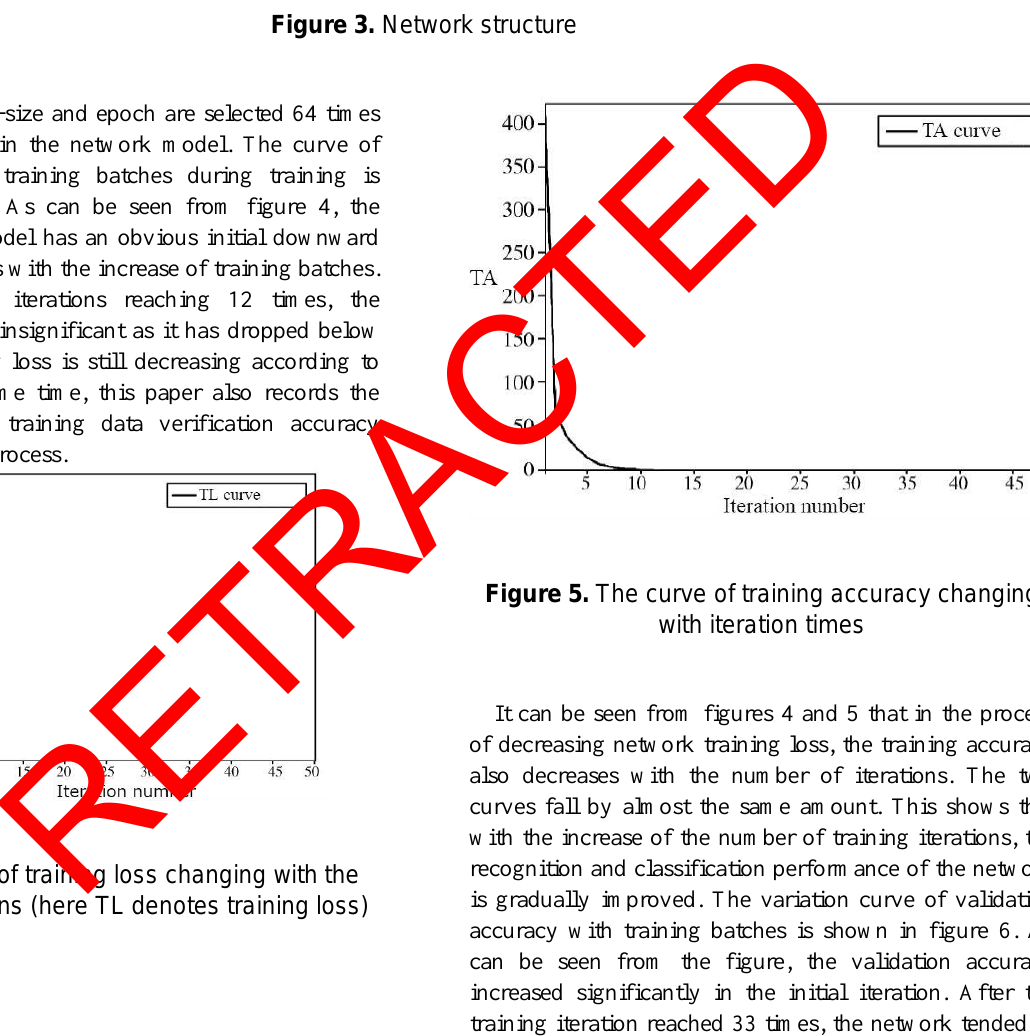
Figure 3. Network structure